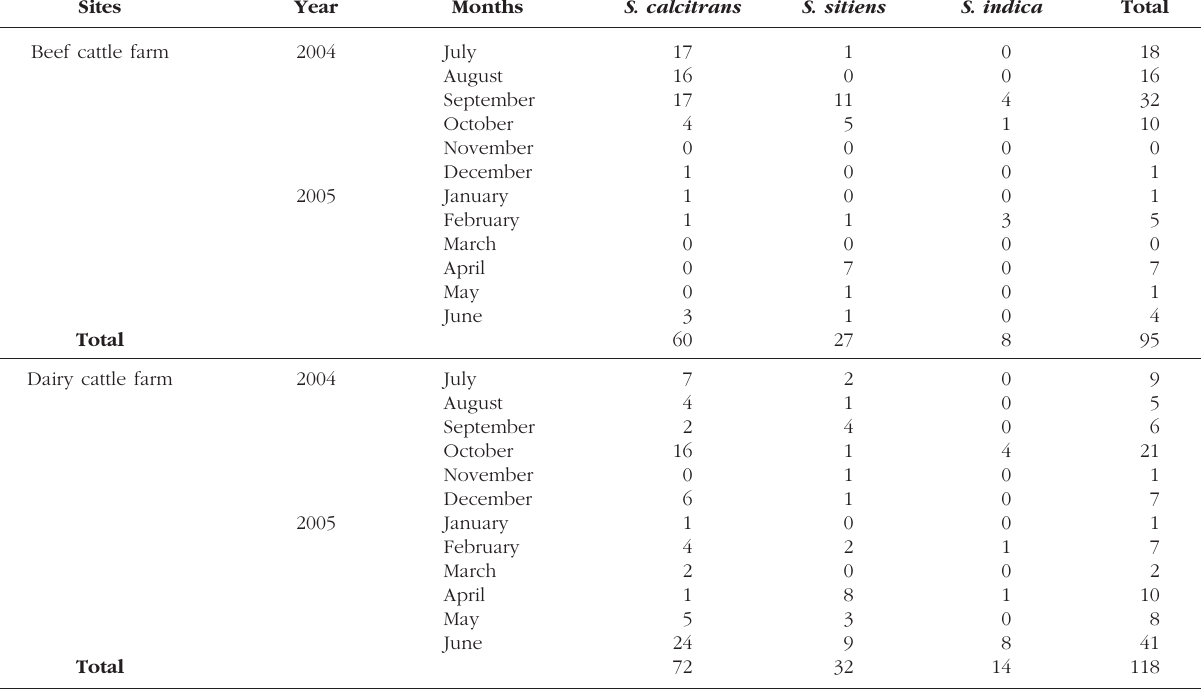
Table I. – Monthly catches of Stomoxys spp. in a beef and a dairy cattle farms, Kamphaengsaen Campus, Nakornpathom province, Thailand from July 2004 to June 2005.